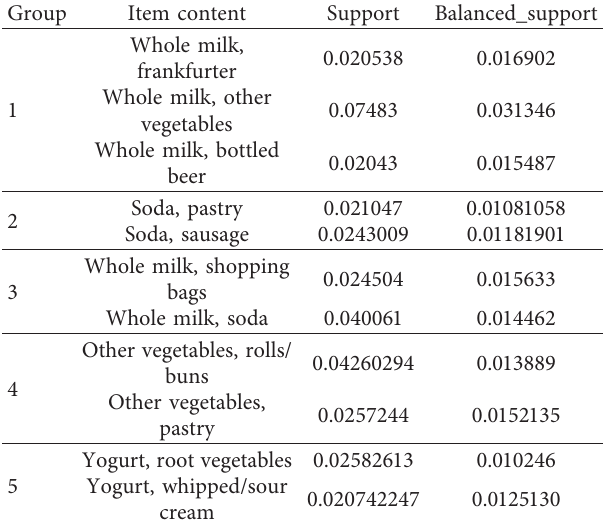
Table 12: Results of ABA on Groceries.